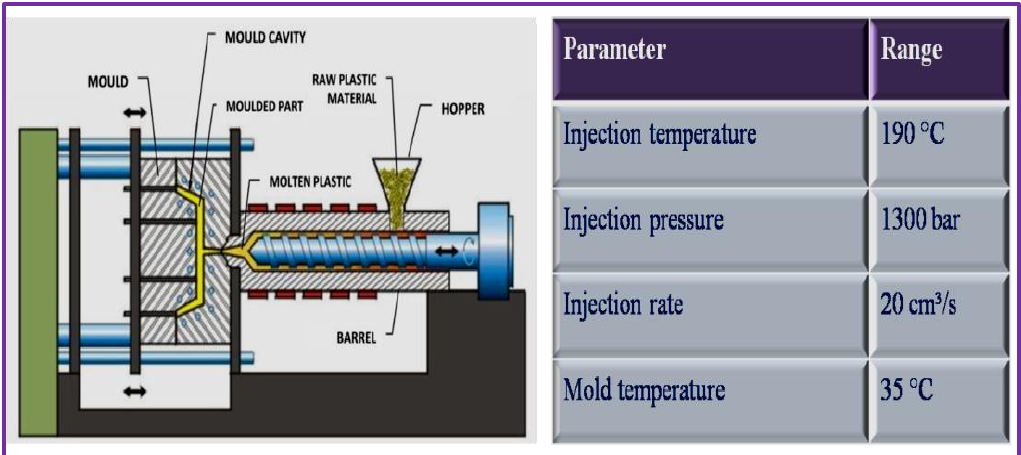
Figure 4. Digital Injection Moulding Machine.